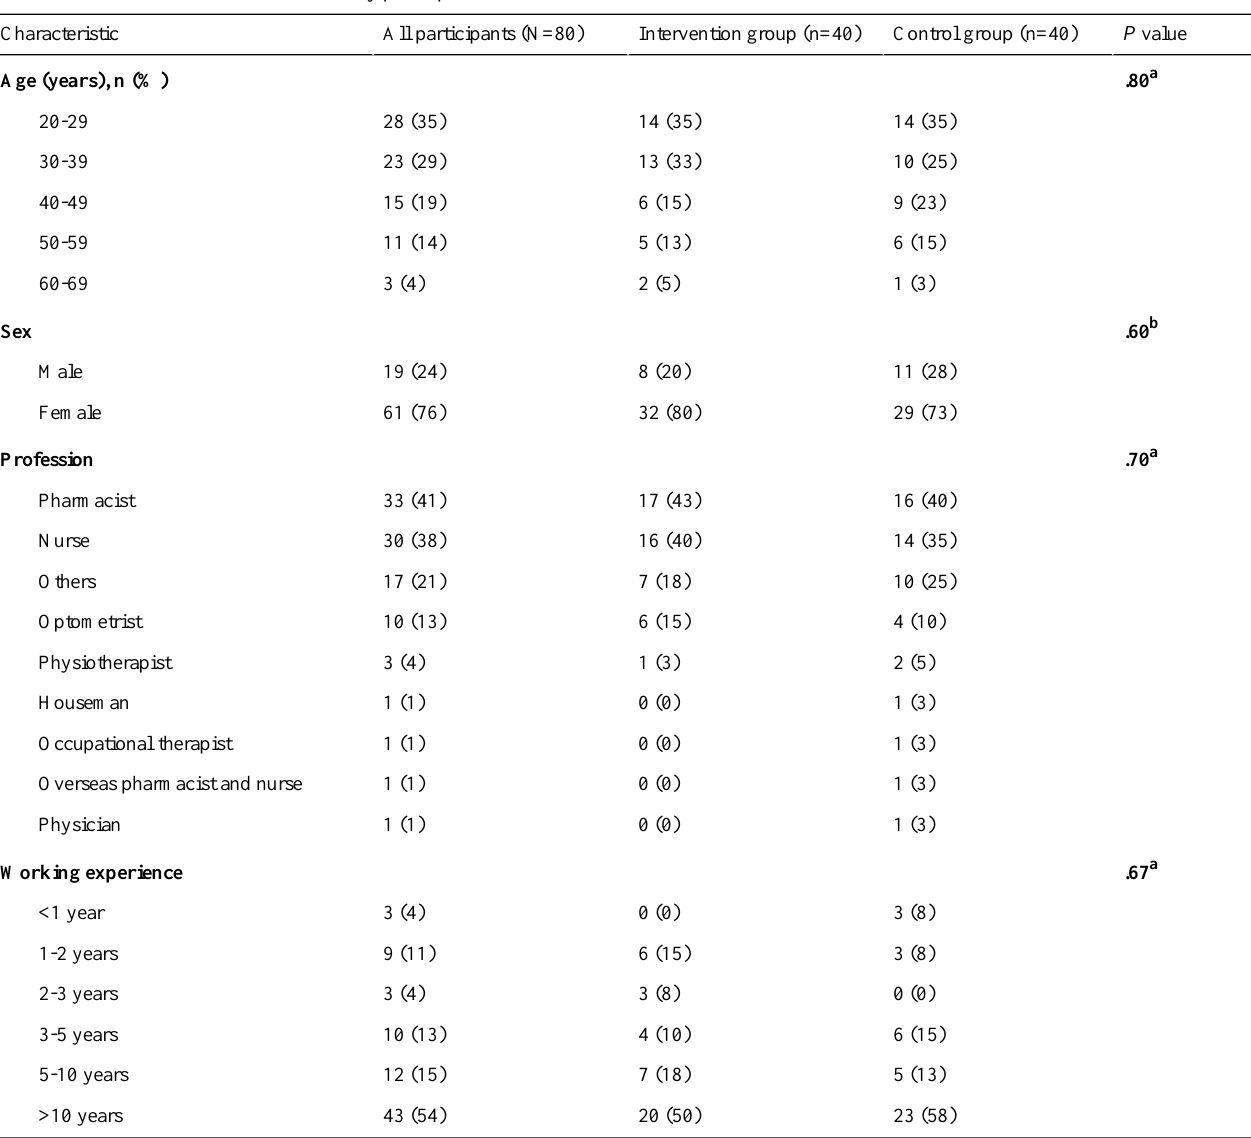
Table 2. Baseline characteristics of the study